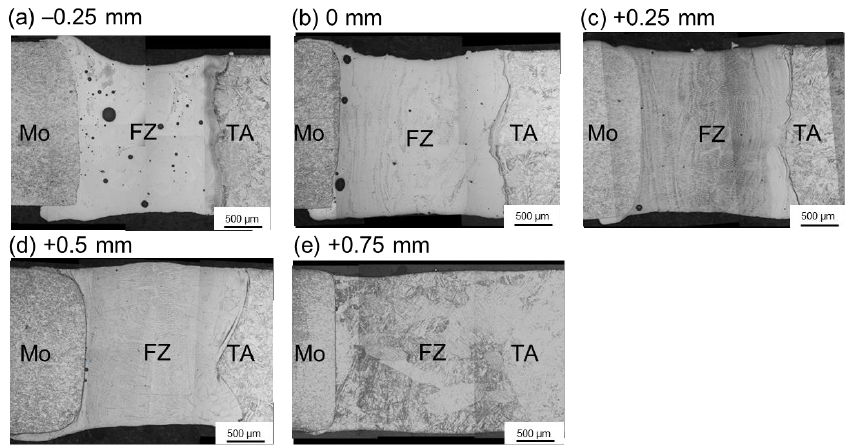
Figure 5. Effects of laser beam offset on the cross-sectional morphologies of Mo/Ti joints. ( a – e ), the cross-sections of welded joints under the offsets of −0.25 mm, 0 mm, +0.25 mm, +0.5 mm, +0.75 mm respectively.